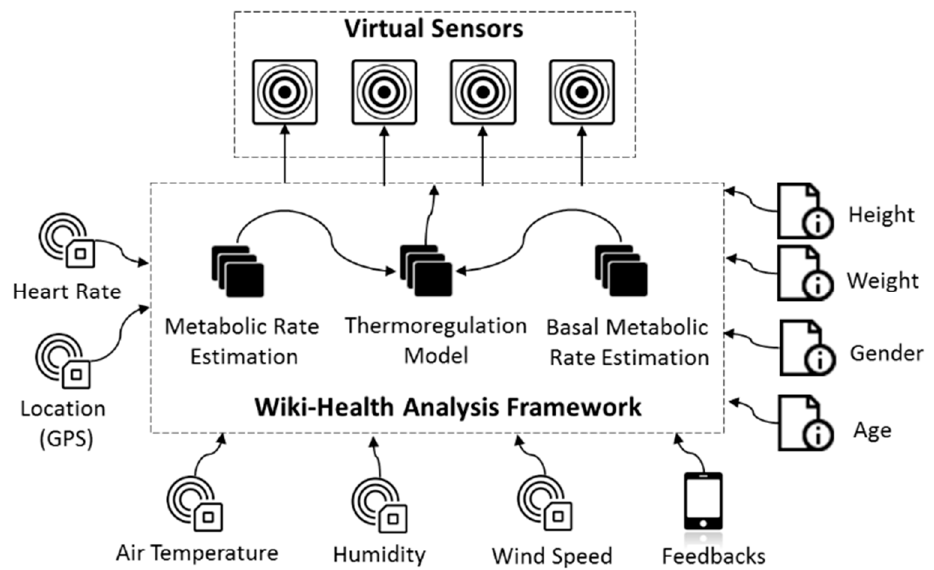
Figure 6. Current implementation of virtual sensors formed by integrating different models and various data sources together.